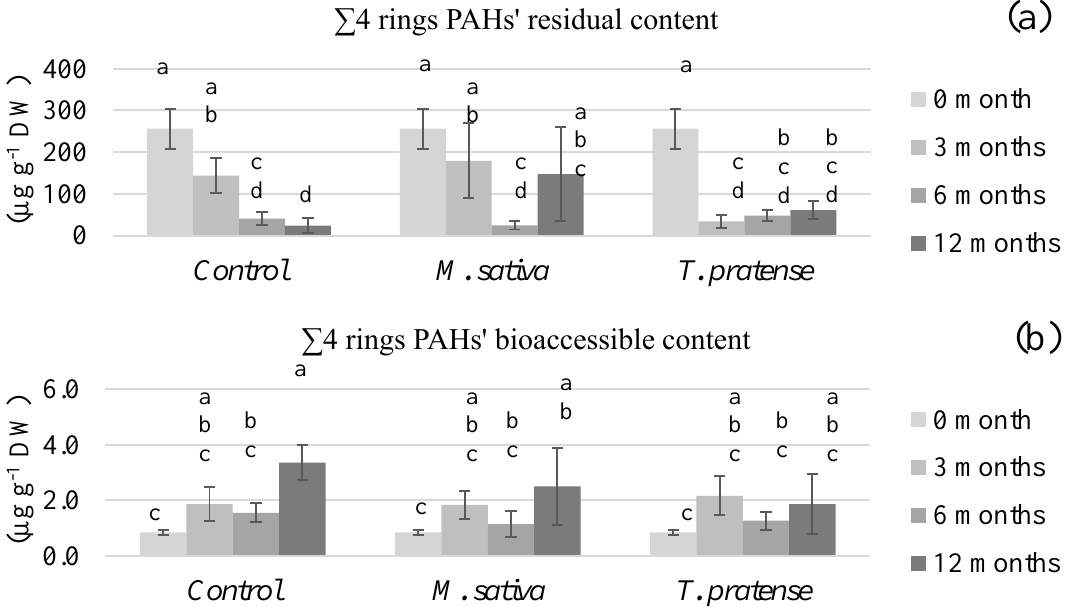
Figure 3. The light PAHs’ (∑2–3 rings) ( a ) residual and ( b ) bioaccessible content of soils planted with M. sativa L. or T. pratense L. compared to unplanted control samples after different time periods. The values are means ± confidence interval (α = 5%, n = 5). There is a significant interaction between the type and the time of culture, so within each PAH fraction (residual or bioaccessible) sticks that share the same letter are not significantly different ( p > 0.05).